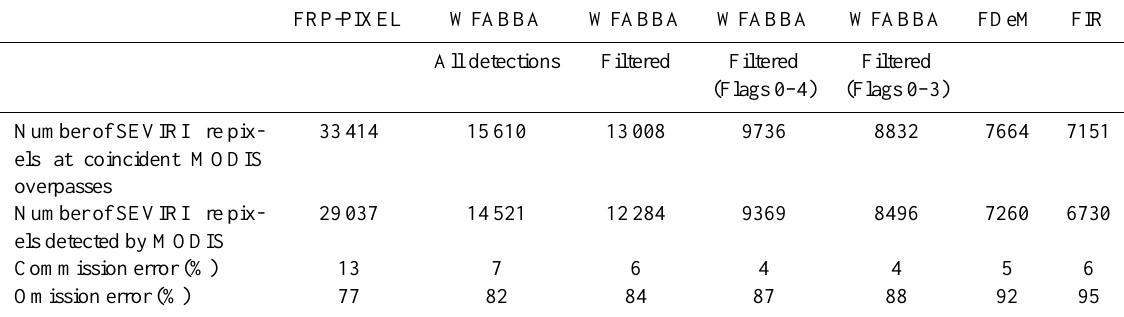
Table 2. Summary of active fire pixel detection errors of omission and commission for the four SEVIRI-derived active fire products explored herein (LSA SAF FRP-PIXEL product; Wooster et al., 2015, WF-ABBA; Prins et al., 1998, FDeM; Amraoui et al., 2010, and FIR; Joro et al., 2008). Data were collected over the LSA SAF Southern Africa geographic region during August 2014, when fire activity is widespread in this area. The MODIS active fire products (MOD14 and MYD14; Giglio et al., 2003) acted as the independent data source for the comparison.